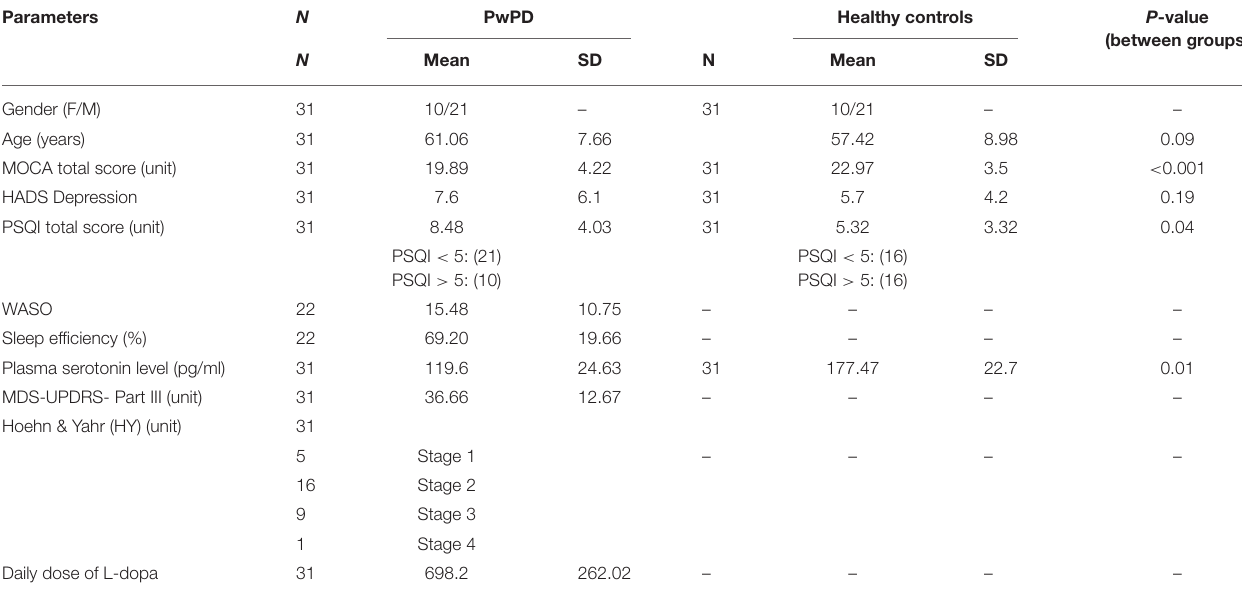
TABLE 1 | Demographic and clinical data of participants in both groups.